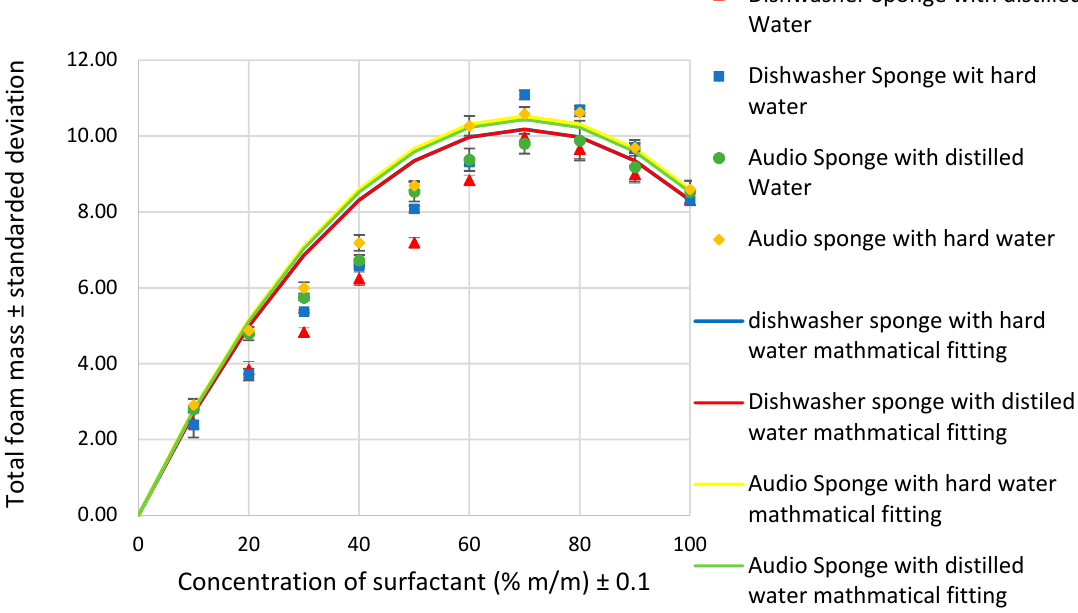
Figure 7. Average total foam mass for both the dishwasher sponge and the audio sponge for each concentration of surfactant, fitted according to Equation (2) with M min = 8.31 and c max = 0.7 for distilled water with a dishwasher sponge, M min = 8.31 and c max = 0.7 for hard water with a dishwasher sponge, M min = 8.52 and c max = 0.7 for distilled water with an audio sponge and M min = 8.59 and c max = 0.7 for hard water with an audio sponge [8].